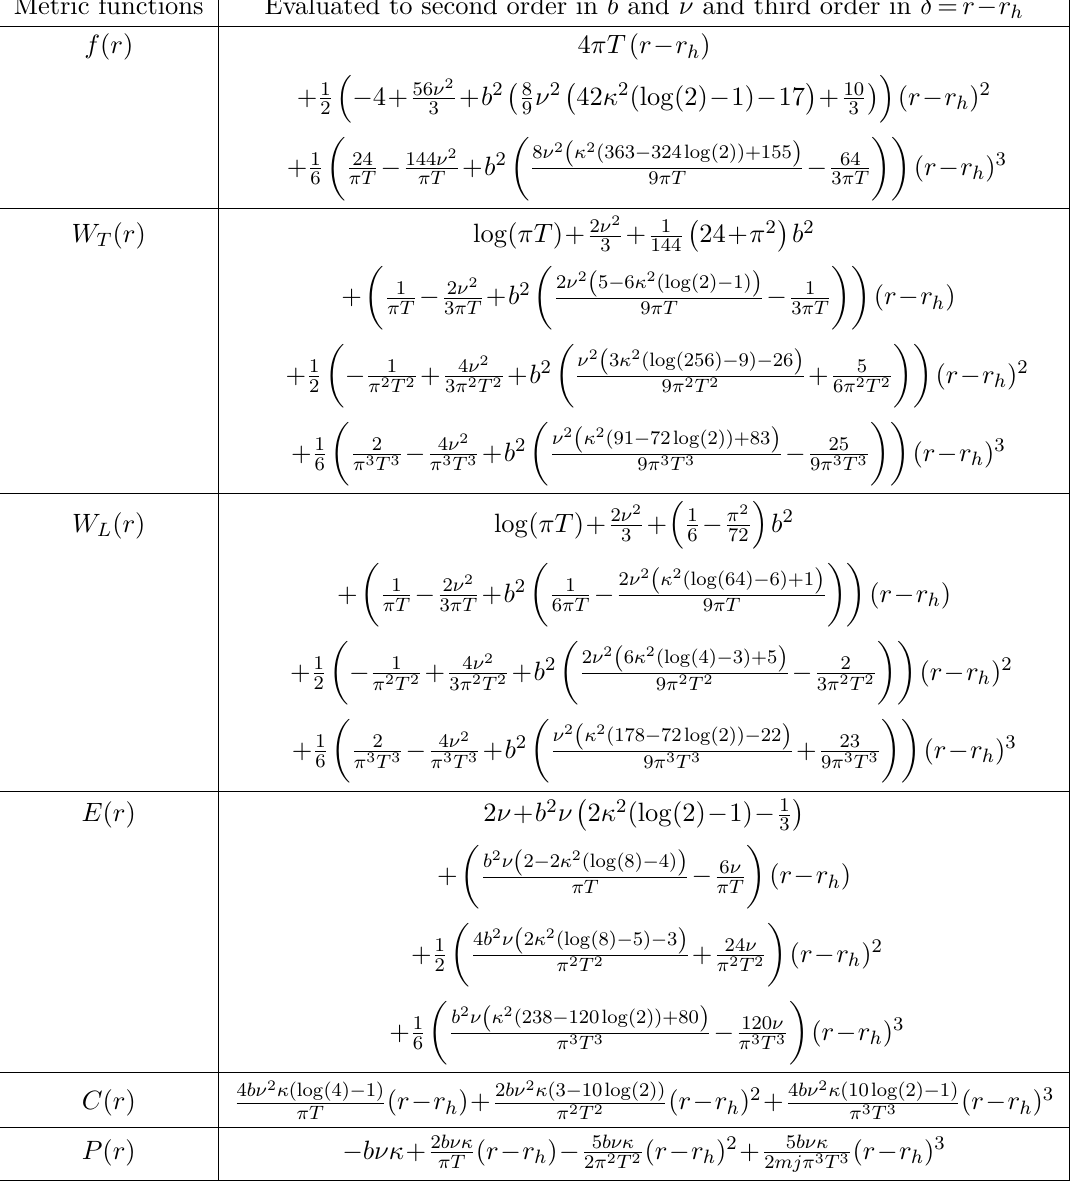
Table 1 . The near the horizon expanded metric functions (2.5) and (cid:12)eld strength (2.6), given to second order in (cid:23) and b